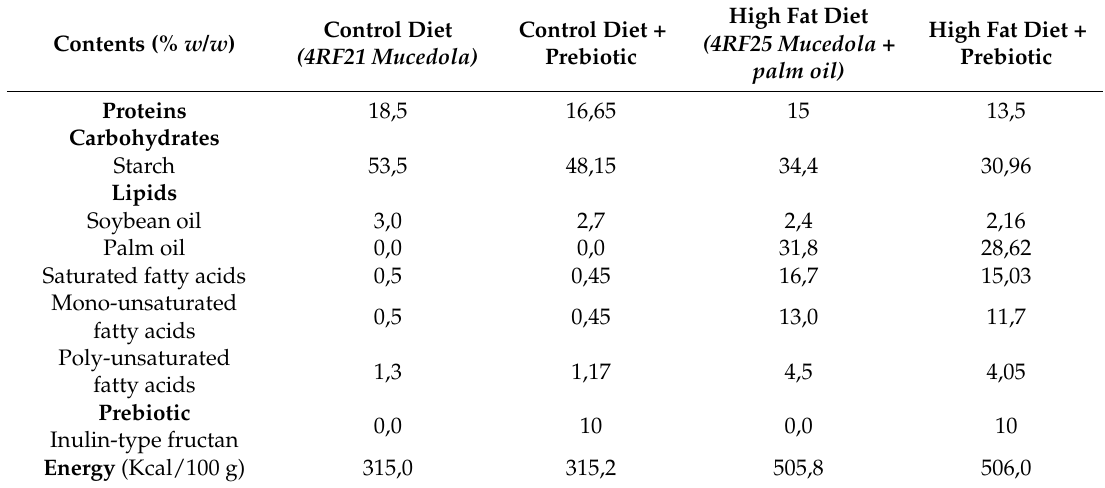
Table 1. Composition of the